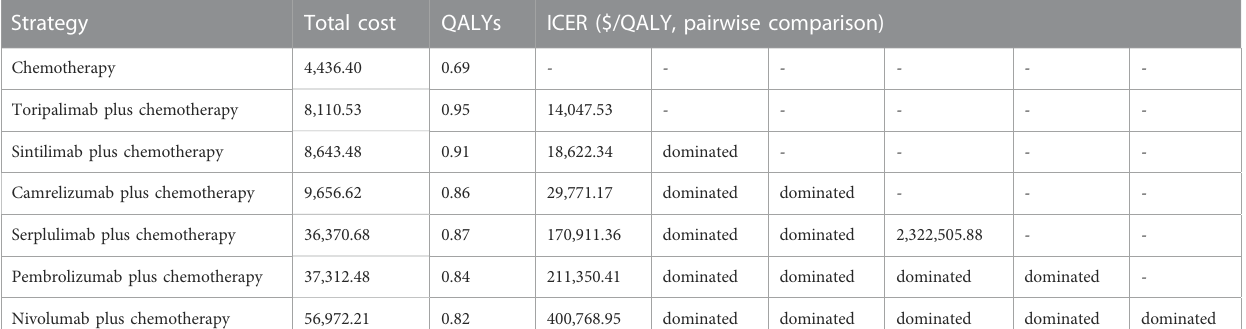
TABLE 3 Base-case results. Strategy Total cost QALYs ICER ($/QALY, pairwise comparison)